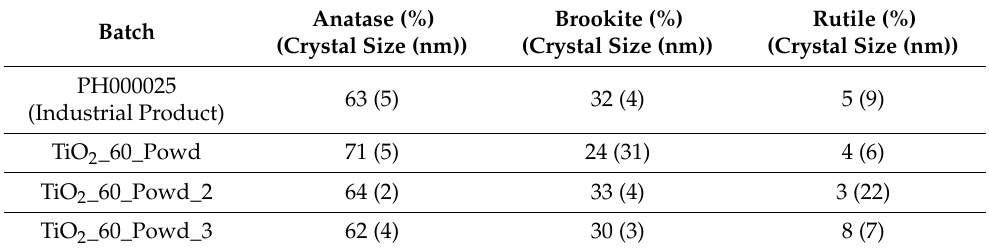
Table 4. Mineralogic composition of the samples TiO 2